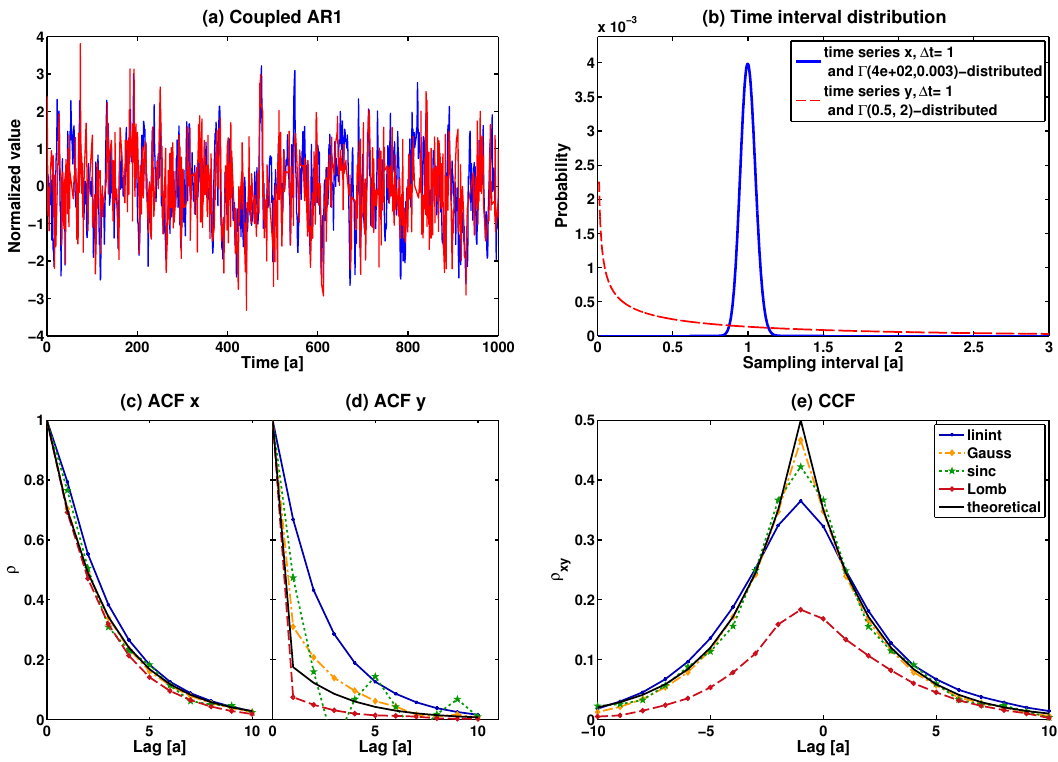
Fig. 7. Cross correlation analysis for two irregularly sampled signals (cf. Eqs. 15, 16) from different sampling schemes: Sample time series (a) and sampling time interval histograms (b) , the mean ACFs out of 100 realizations (c) and the mean estimated CCF (d) . Legends for each row are given in the right panels. A positive bias in interpolation ACF estimates and a negative bias in the interpolation and LS CCF estimates is observable for increased sampling irregularity.